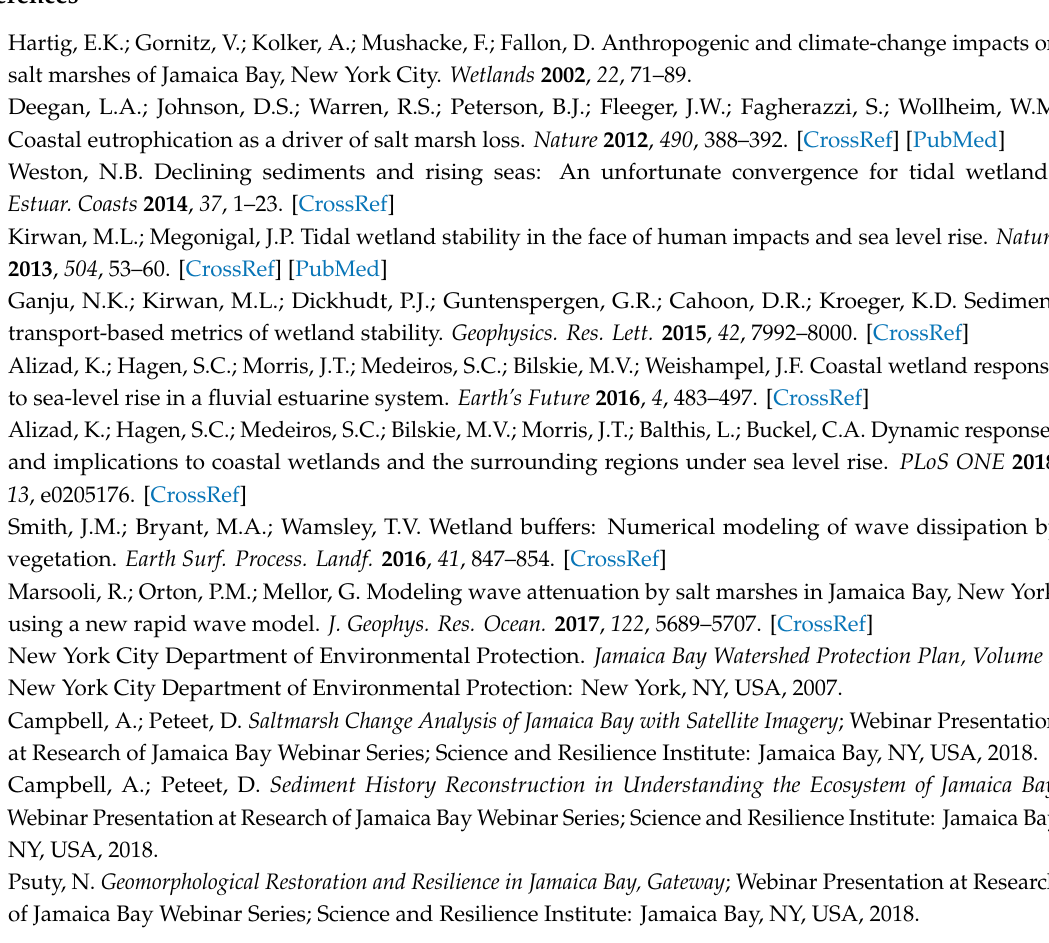
Figure A2. PINK LADY Path (shown by the blue line) and Speed. Source [66].